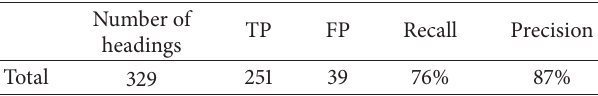
Table 3: Evaluation results for the heading detection task.